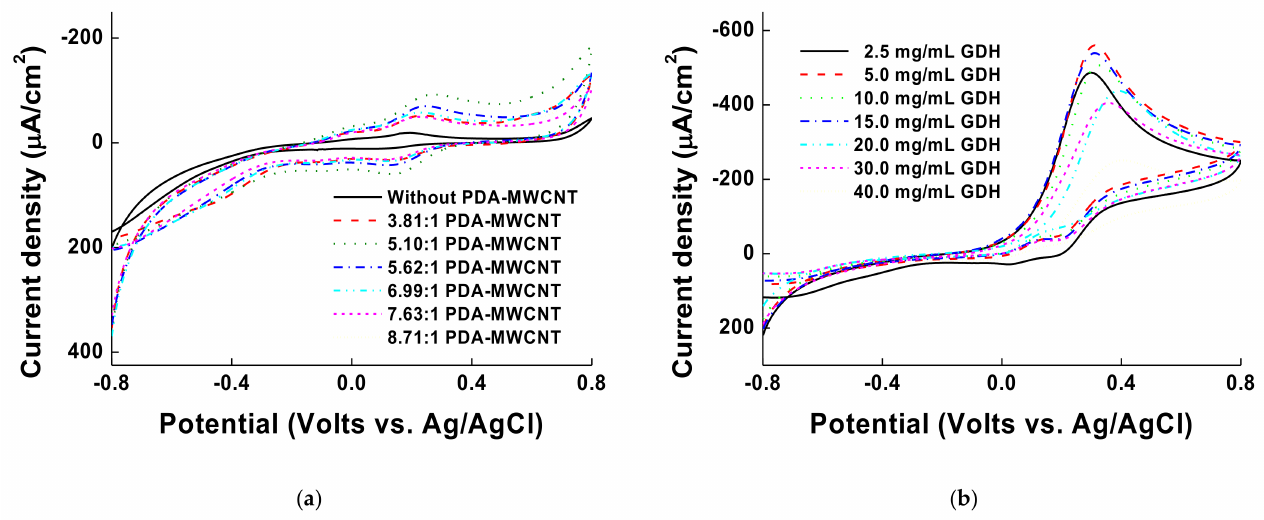
Figure 3. Cyclic voltammograms for optimization of ( a ) PDA-MWCNT ratio and ( b ) GDH amounts onto the